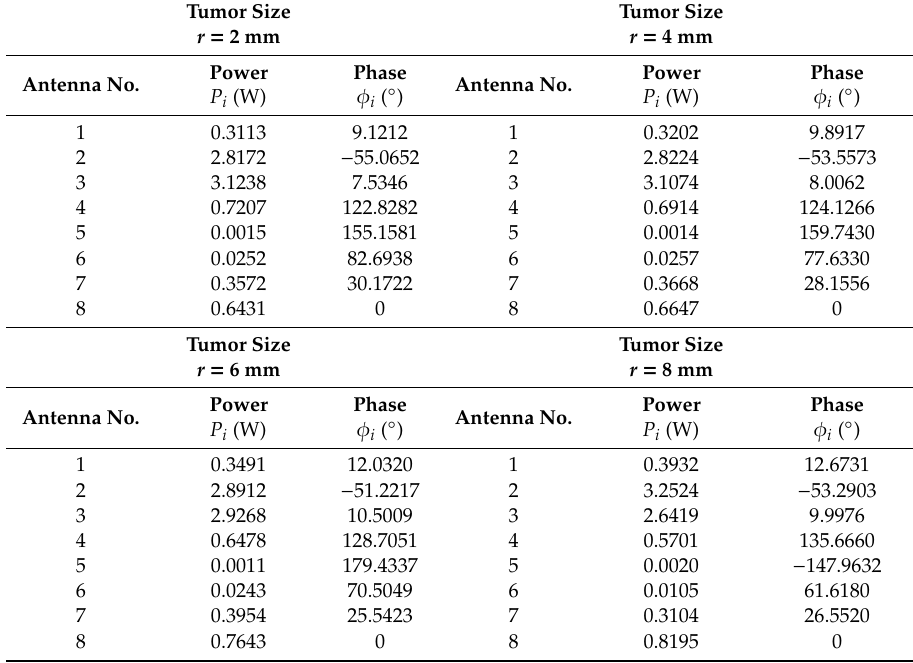
Tumor Size r = 4 mm